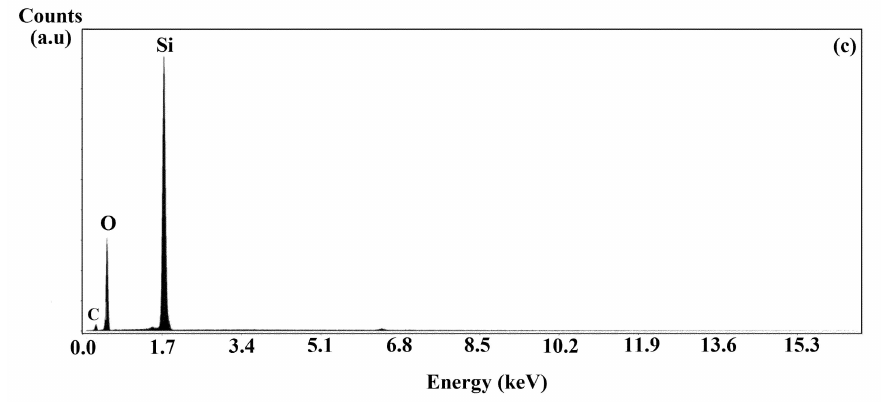
Figure 4. EDS spectra corresponding to the zones of the images in Figure 2, ( a ) SiO 2 SilB sample, ( b ) SiO 2 Siland sample without dispersion, and ( c ) SiO 2 Silad3.5 sample with dispersion.